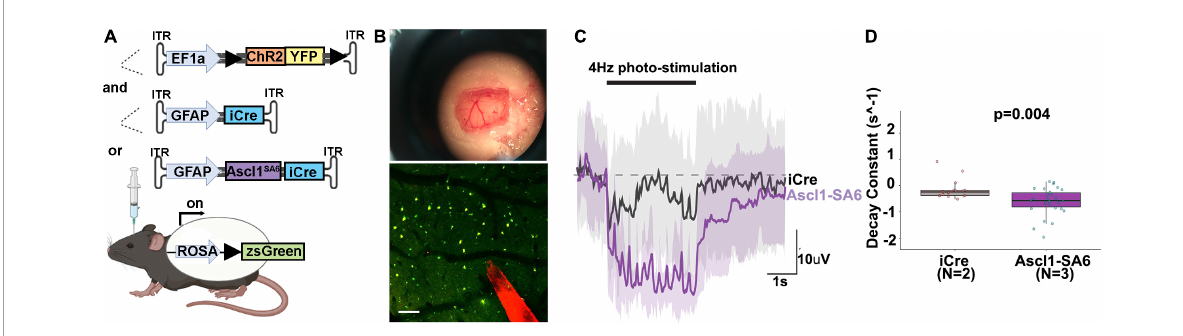
FIGURE7 Optogenetic stimulation of ChR2 actuator reveals that Ascl1 SA 6 transduced cells have a shorter decay constant. (A) Schematic illustration of optogenetic experiment in which we injected AAVs carrying ChR2-(H134R)-YFP, an optogenetic actuator, and co-transduced AAV5-GFAPshort-iCre or AAV5-GFAPshort-Ascl1 SA 6 -iCre into the cortex of Rosa-zsGreen mice. A 4 weeks later, photostimulation experiments were performed. (B) Craniotomy and cortical window used for simultaneous photostimulation and electrophysiological recordings. Also shown is a two-photon z-stack projection of the cortical tissue showing zsGreen + cells (green channel) and the tungsten electrode tip (red channel); the circular yellow area represents the site of stimulation near the electrode; scalebar = 100 µ m. (C) Representative raw voltage traces showing the changes in the LFP band following 3 s of photostimulation at 4 Hz for both Ascl1 SA 6 (purple trace) and iCre (black trace) treatments. Shaded areas indicate the voltage standard deviation measured across different repetitions, within the same photostimulated area. (D) Measurement of the decay constant of photostimulated cells in iCre and Ascl1 SA 6 transduced brains. Dots in the boxplots indicate individual measures and “N” indicates the number of mice used in each group. Significance was defined as p -values less than 0.05 and denoted as follows: ns, not significant, < 0.05 *, < 0.01 **, < 0.001